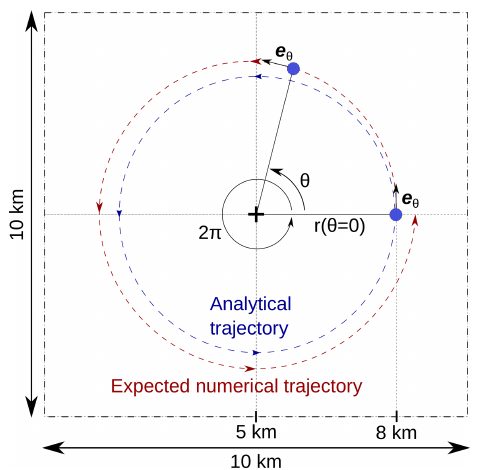
Figure D1. Model setup for the 2-D free surface